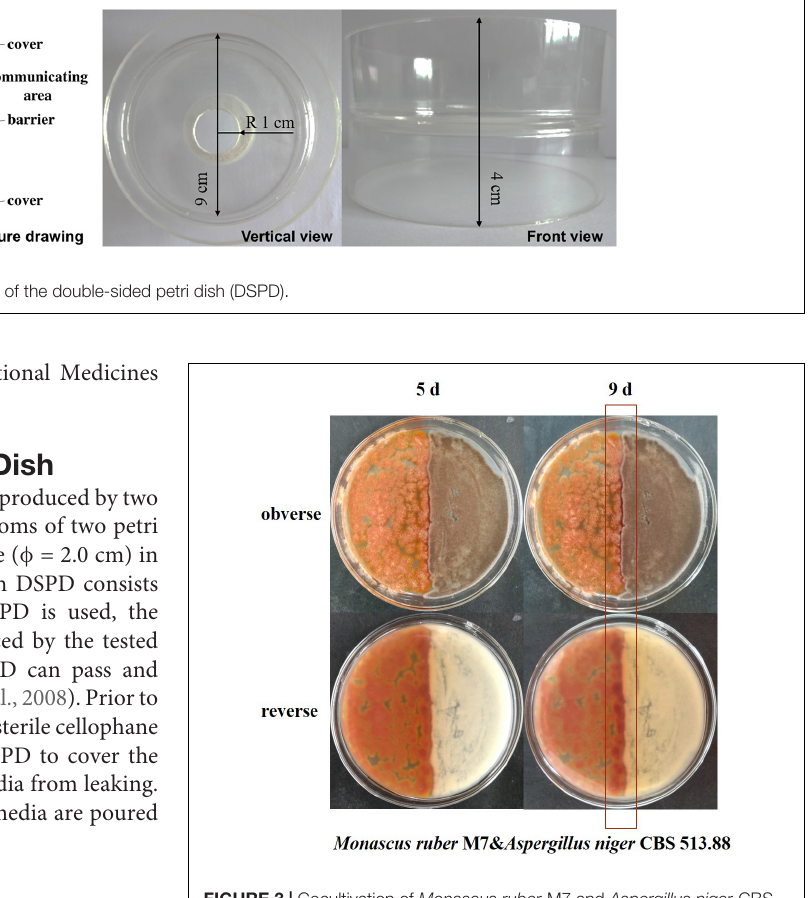
FIGURE 3 | Cocultivation of Monascus ruber M7 and Aspergillus niger CBS 513.88 by coating inoculation method at 5 and 9 days &-co-cultured